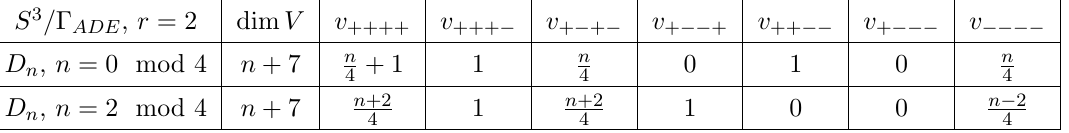
for (cid:7) = Z (1) (cid:2) Z (2) (cid:15) A 1 (cid:15) B 1 (cid:15) A 2 (cid:15) B 2 2 2